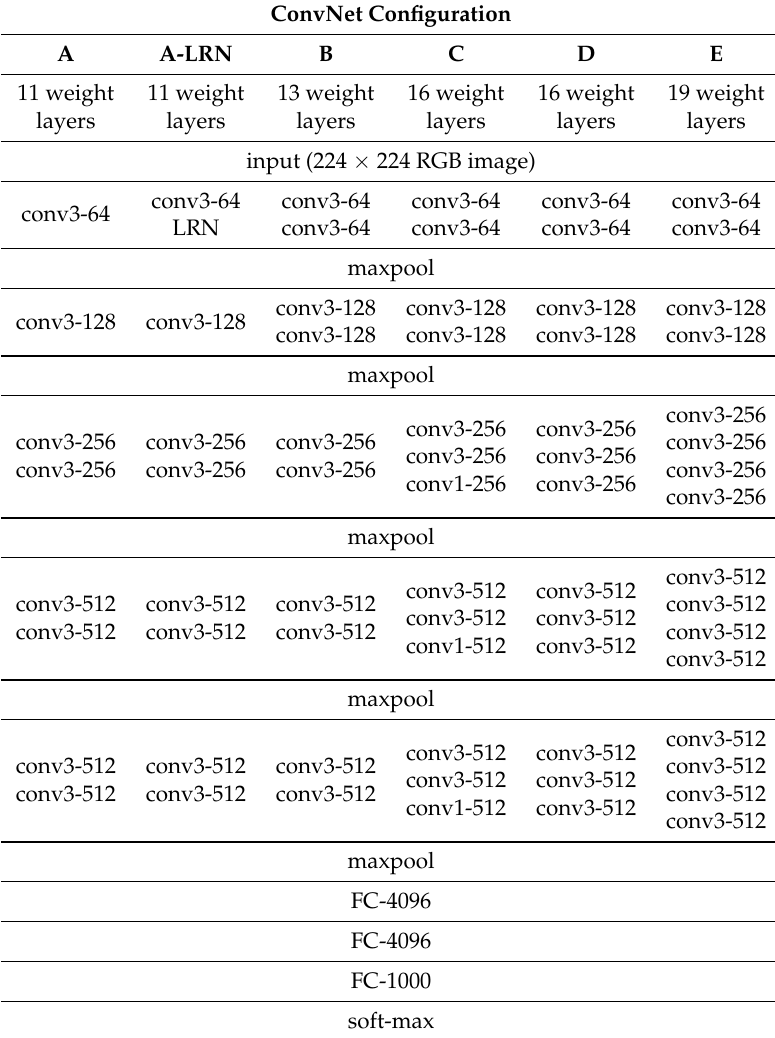
Table 2. VGG-16 configuration (shown in columns). Configuration depth increases from the left (A) to the right (E) as more layers are added (added layers are shown in bold). Convolutional layer parameters are denoted as “conv(receptive field size)-(number of channels)”. ReLU activation function is omitted for